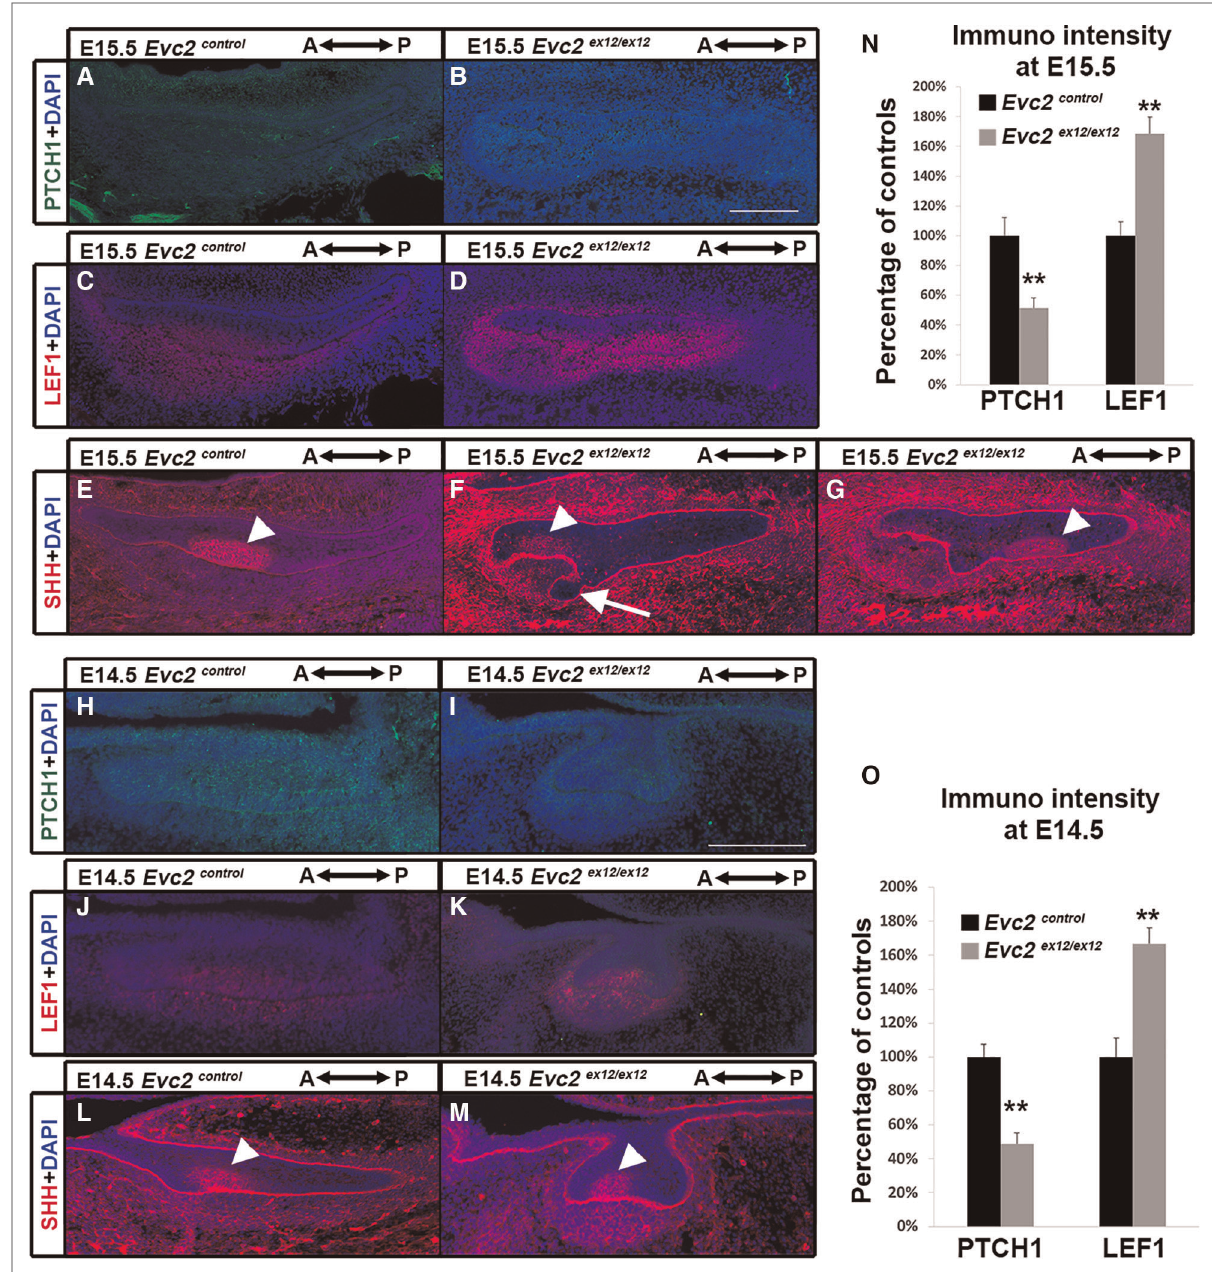
FIGURE 6 Evc2 mutation leads to decreased Hedgehog signaling and increased WNT signaling at E14.5 and E15.5. Mandible molars from E15.5 ( A – G ) and E14.5 ( H – M ) were immunolabeled with PTCH1 ( A,B,H,I ) for reading out Hedgehog signaling; LEF1 ( C,D,J,K ) for reading out WNT signaling; and SHH ( E,F,G, L,M ) for indicating enamel knot. In Evc2 mutants, two enamel knots were not on the same section plain. Thus, two sections with enamel knot were shown in F and G separately. The immunosignal for PTCH1 and LEF1 from E15.5 molars were quanti fi ed and shown in N. The immunosignal for PTCH1 and LEF1 from E15.5 molars were quanti fi ed and shown in O. ( n =4; **, p <0.01). White arrow indicates abnormal shaped epithelia. White arrowheads indicate enamel